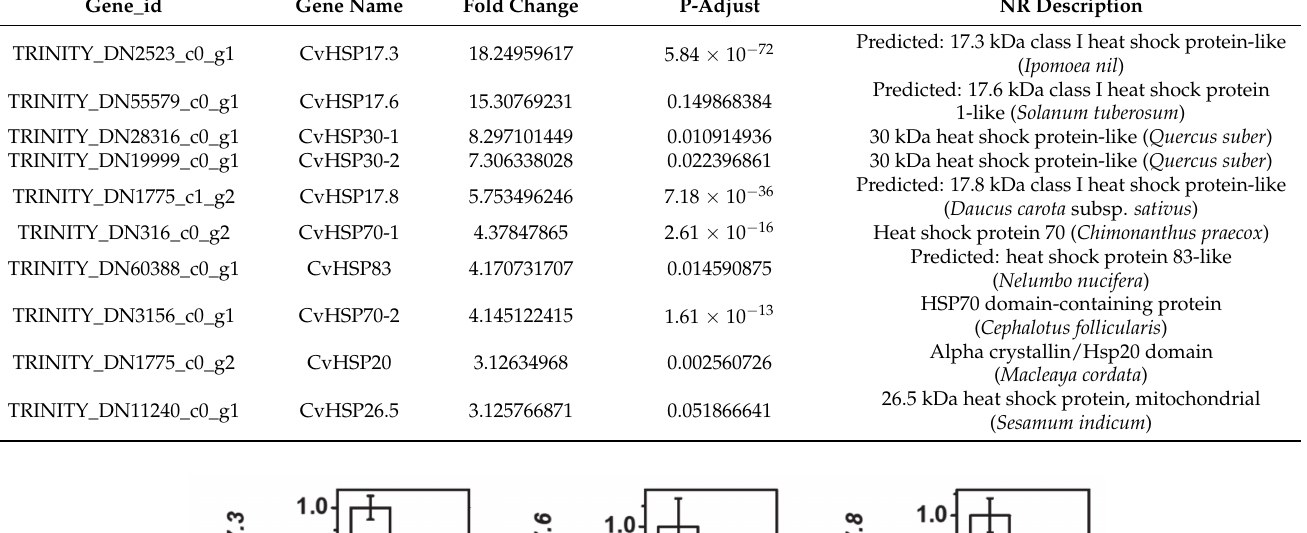
Table 1. Differently expressing heat shock proteins (HSPs) before and after heat treatment ( p < 0.05).